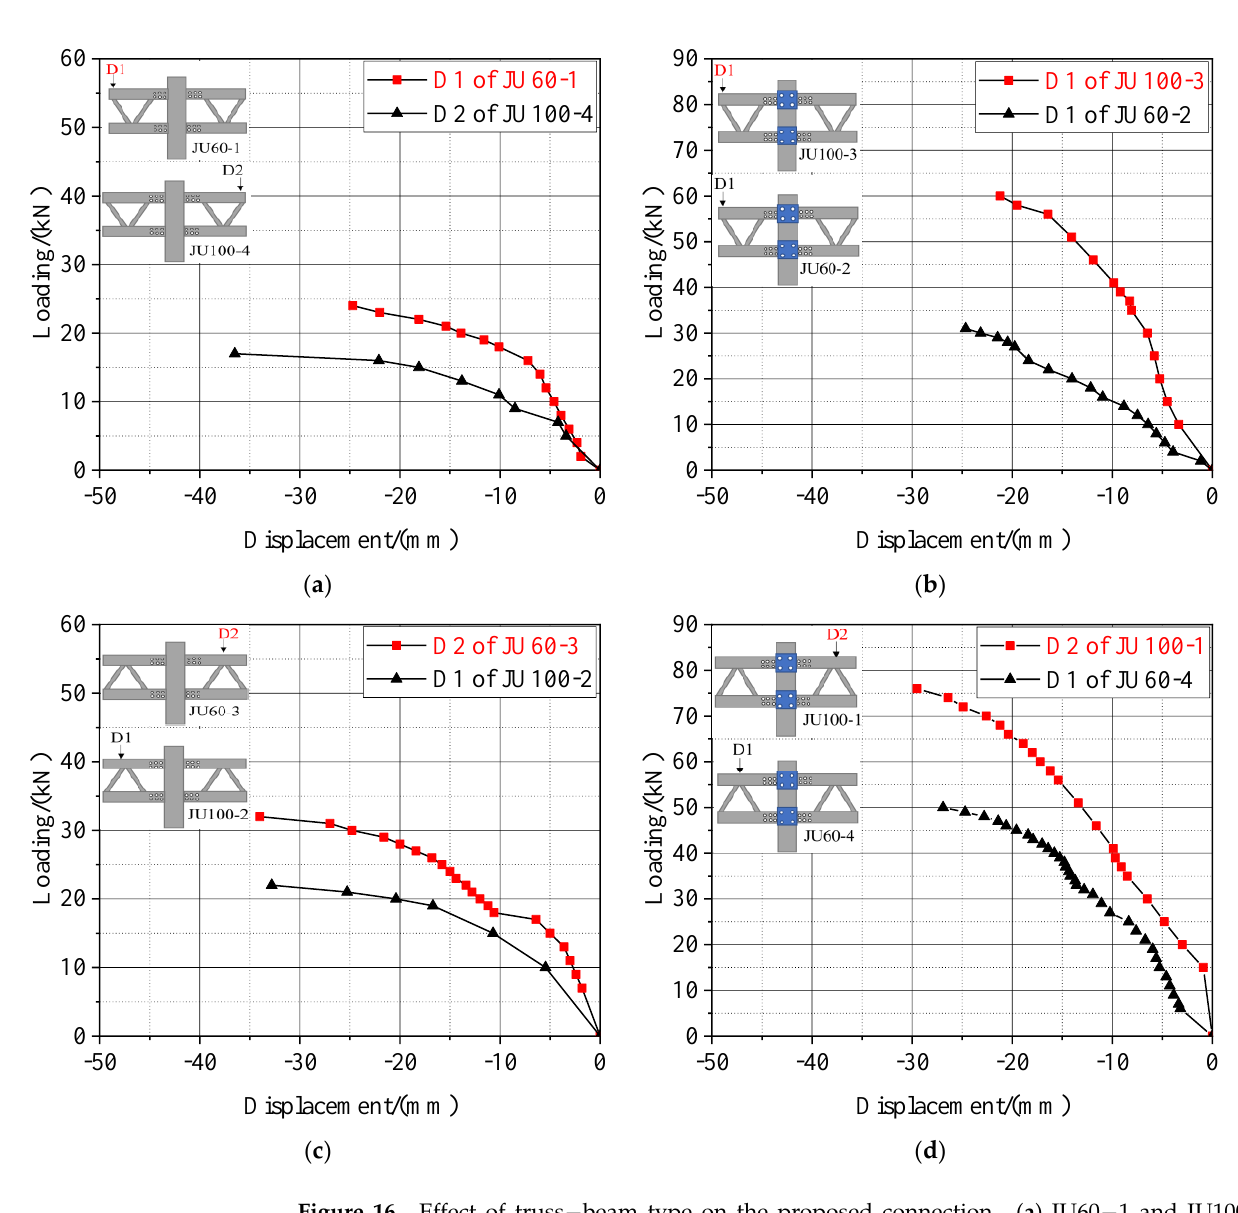
Figure 16. Effect of truss − beam type on the proposed connection. ( a ) JU60 − 1 and JU100 − 4, ( b ) JU60 − 2 and JU100 − 3, ( c ) JU60 − 3 and JU100 − 2, ( d ) JU60 − 4 and JU100 − 1.